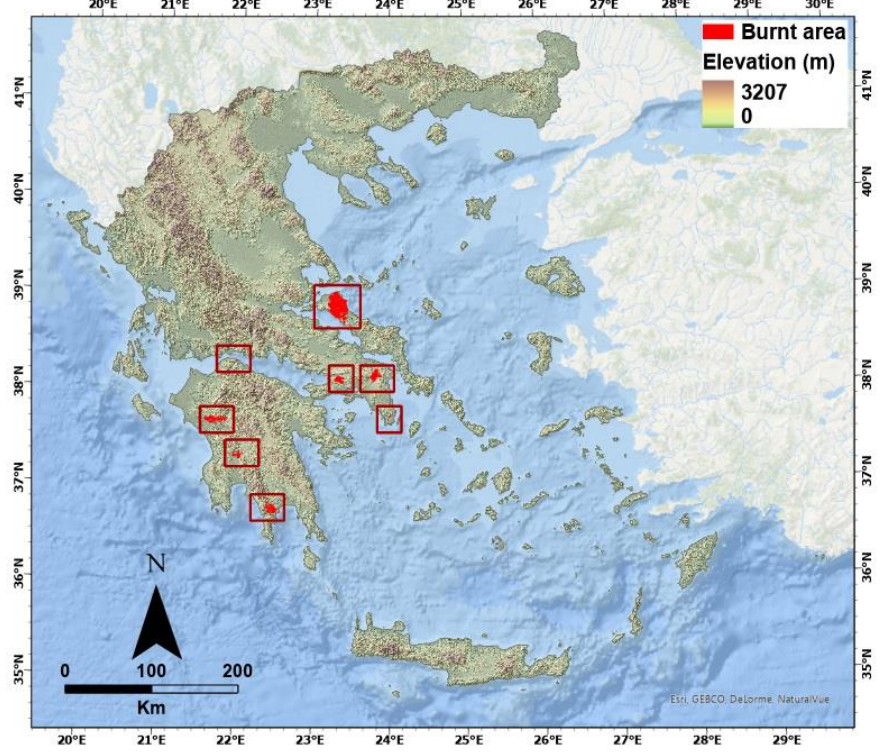
Figure 1. Location of the studied areas. The areas burnt during the 2021 fires are marked with red